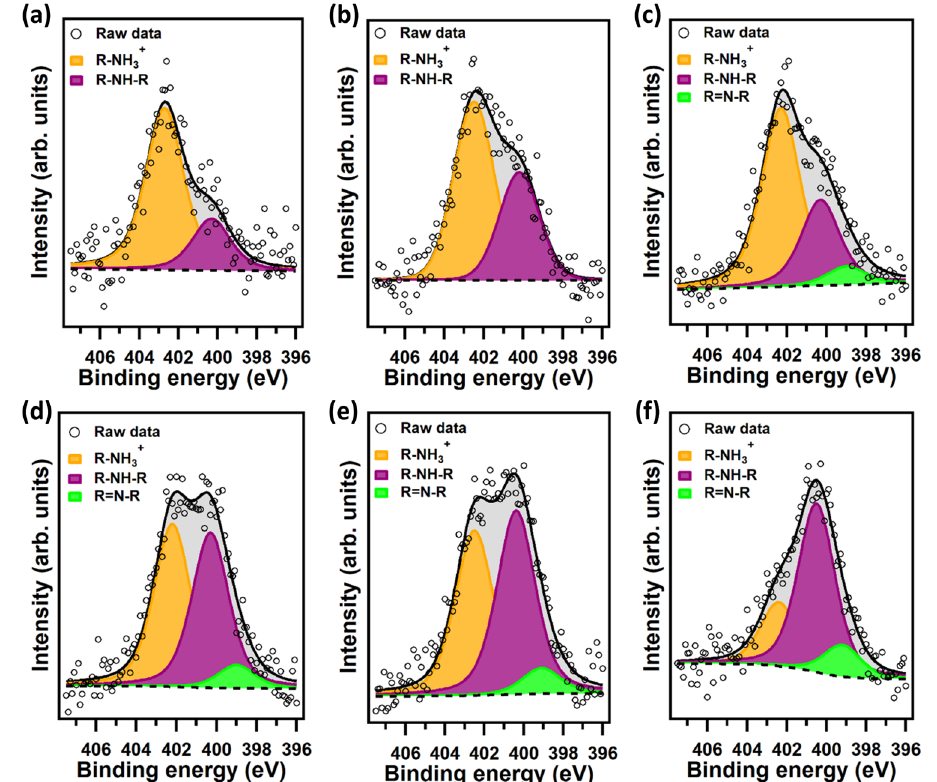
Fig. 6 | XPS analysis of modi fi ed HNT-PDA samples. XPS spectra of the N1 s core level region for HNT-PDA after a 5min, b 15min, c 30min, d 60min, e 120min, and f 240min of polydopamine